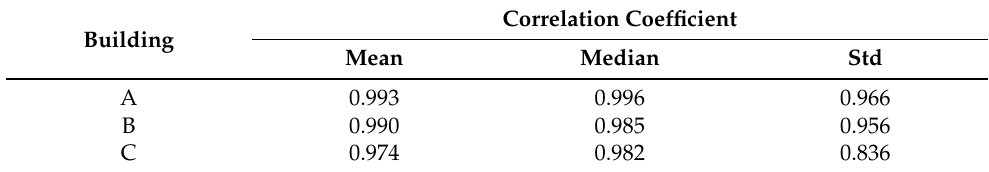
Table 5. Pearson correlation coefficients between the measurements performed at the two probe